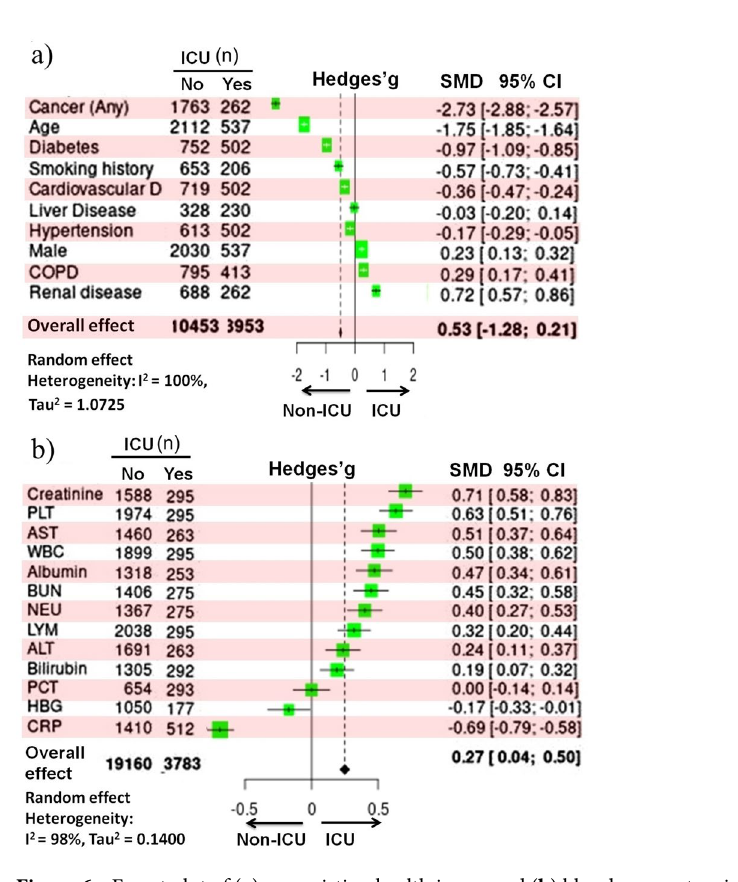
Figure 6. Forest plot of ( a ) pre-existing health issues and ( b ) blood parameters in COVID-19-infected ICU and non-ICU patients. The Standardized Mean Difference (SMD) and the 95% confidence intervals (CIs) were used to define the effect size. n, population size; D, diseases; COPD, chronic obstructive pulmonary disease; S, survivors; NS, non-survivors; ALT, alanine aminotransferase; WBC, white blood cell; PCT, procalcitonin; BUN, blood urea nitrogen; NEU, neutrophil; AST, aspartate aminotransferase; CRP, C-reactive protein; PLT, platelet; LYM, lymphocyte; HBG,